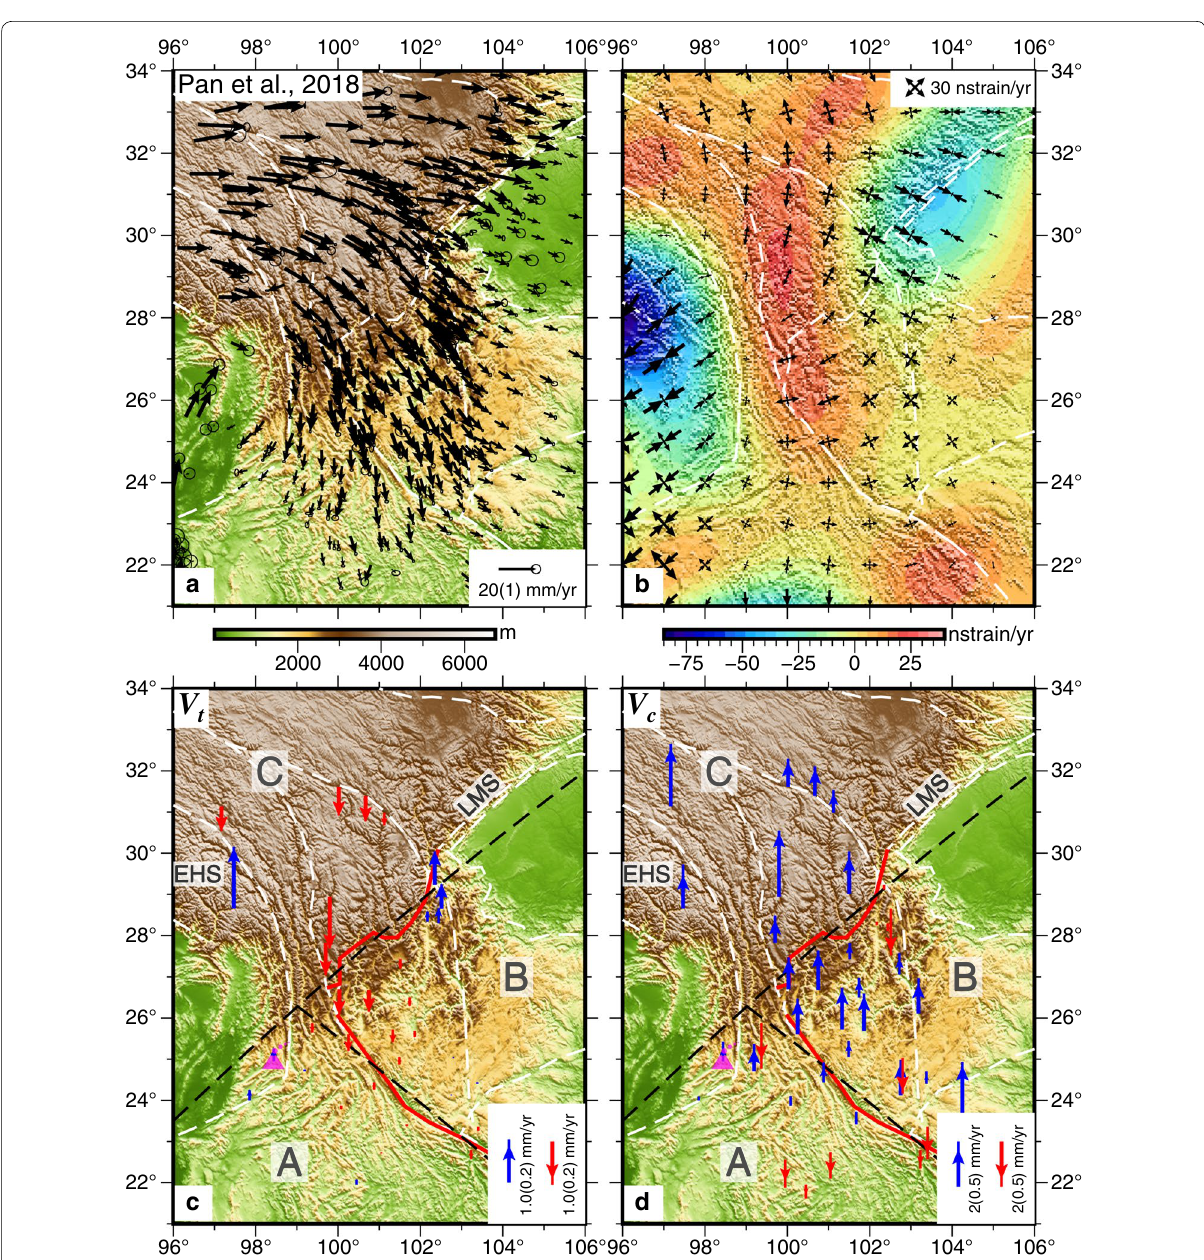
Fig. 3 Observed vertical rates deduced by the three-dimensional GPS rates. a GPS horizontal rates field from Pan et al. (2018) including the data from the continuous and campaign stations. b Dilatational rates deduced by the GPS horizontal rate field using least-squares collocation (LSC) (Wu et al. 2011). c Vertical rates ( V t ) transferred from the dilatational rates. LMS denotes the Longmen Shan area. EHS denotes Eastern Himalayan Syntaxis. d Vertical rates ( V c ) due to rheological deformation. V t is subtracted from V o (Fig. 2d) to obtain V c . The meaning of the symbols and lines is the same as in Fig.